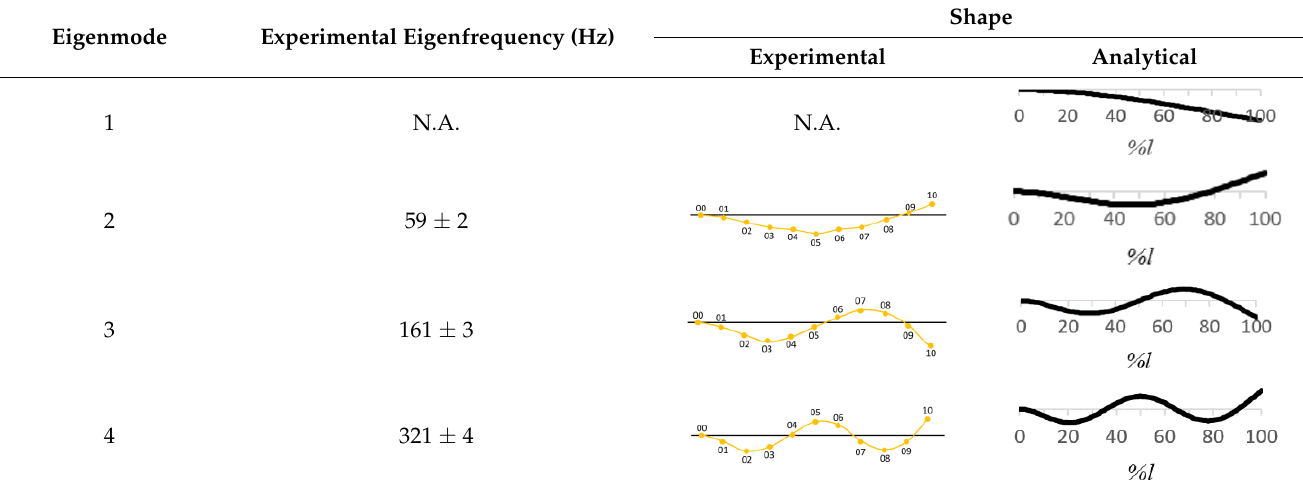
Table 1. Experimental eigenfrequencies and comparison with analytical eigenmodes.